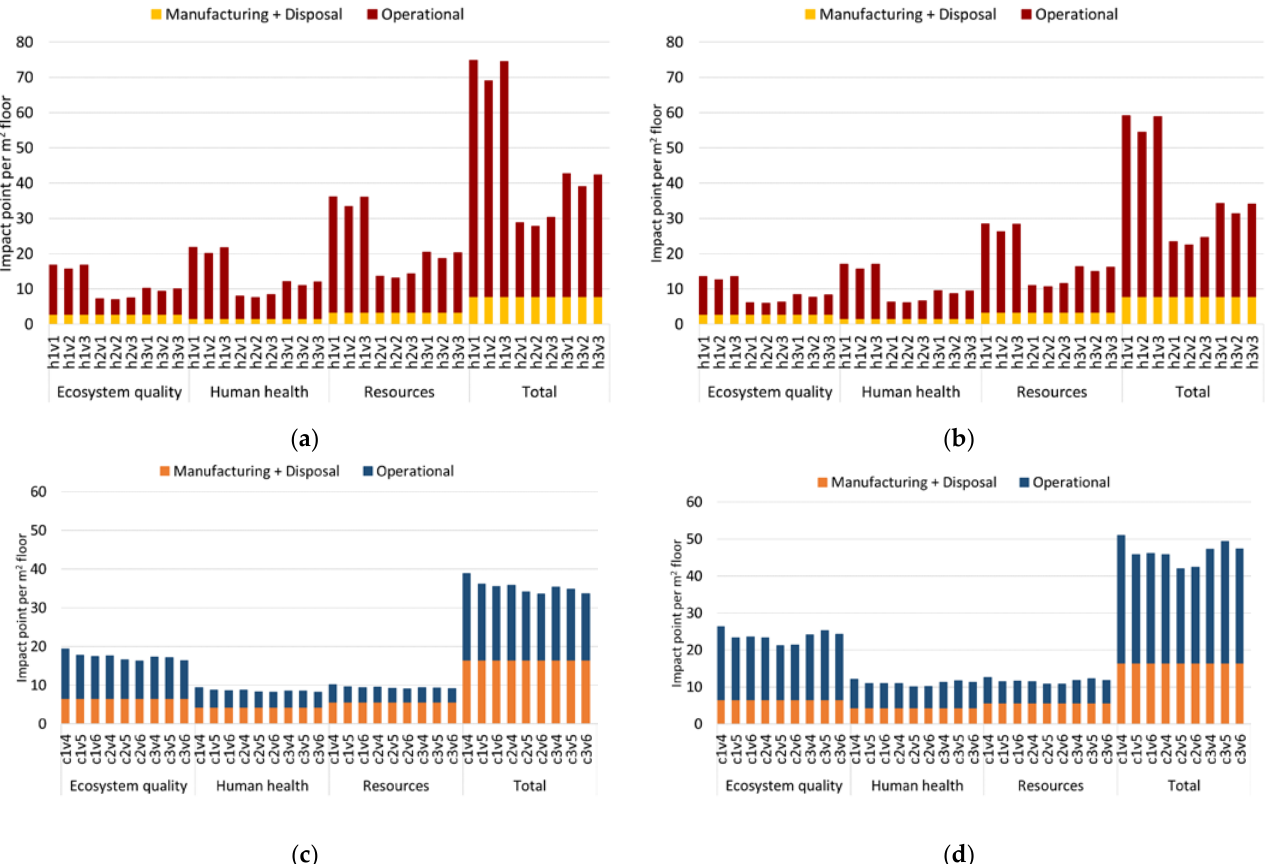
Figure 7. Comparison of the total results per m 2 of floor area (manufacturing and disposal + operational stage) using the